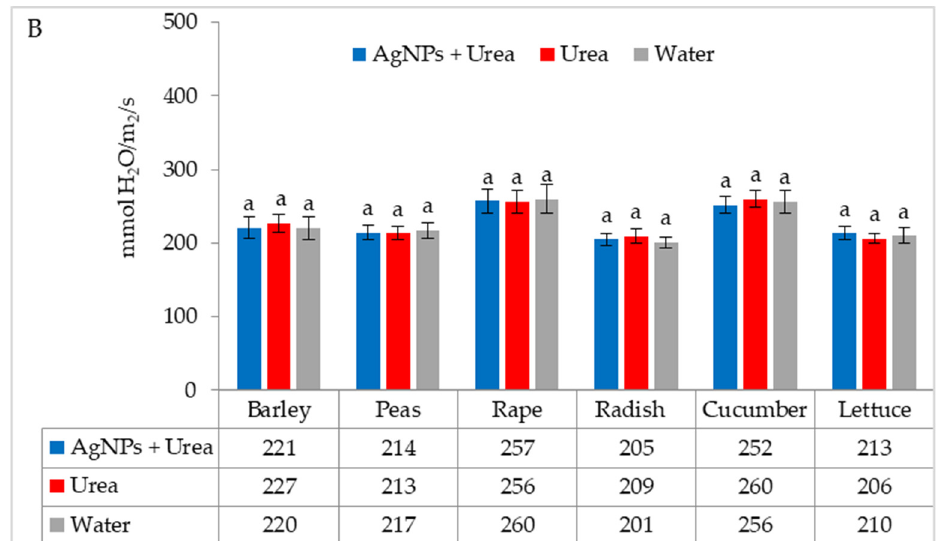
Figure 5. The leaf stomatal conductance of plants under optimal—( A ) and water stress conditions— ( B ) depending on the presence of AgNPs in the substrate; urea solution with AgNPs (AgNPs + Urea), urea solution (Urea), water (Water). a, b—letters indicate a significant difference in the stomatal conductivity for individual plant species at p < 0.05.